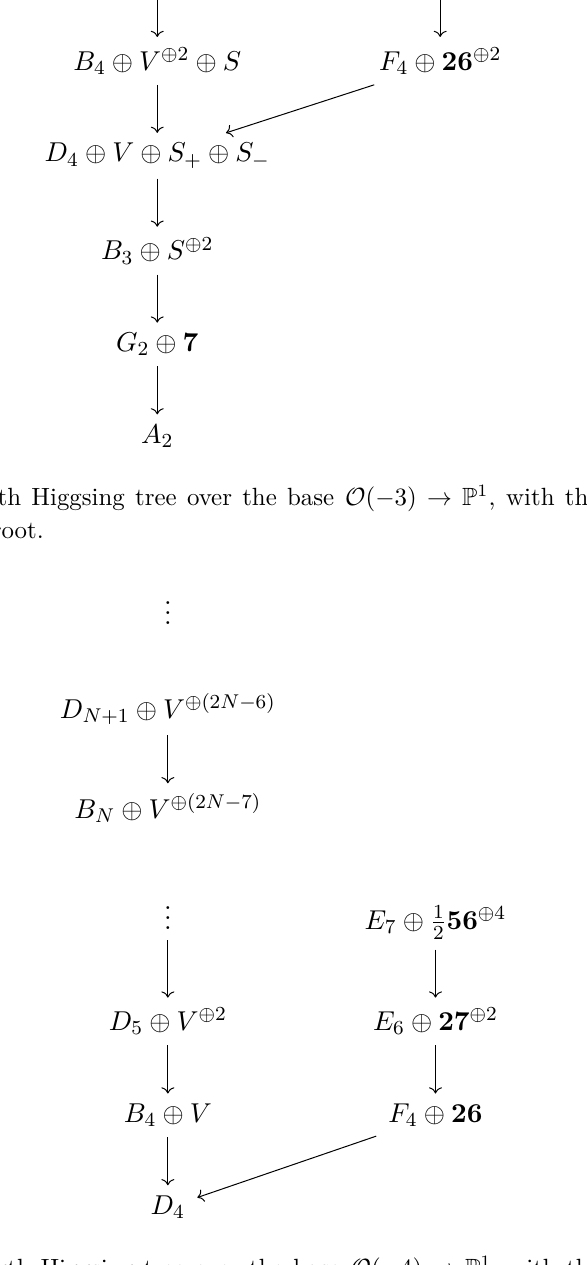
Figure 8 . Infinite length Higgsing tree over the base O ( − 4) → P 1 , with the maximally Higgsed gauge group D at its 4